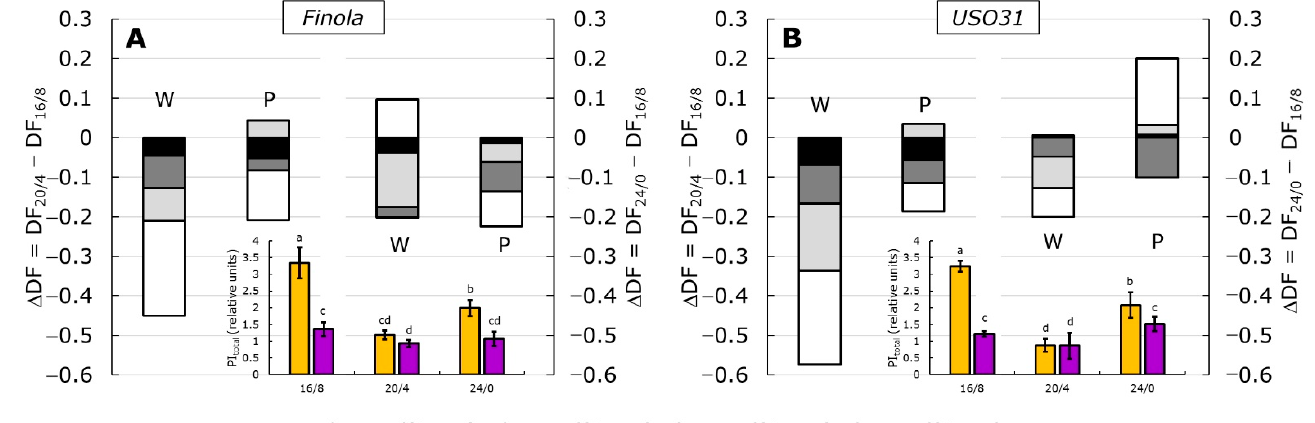
Figure 4. Relative changes in the difference in driving forces ( Δ DF) measured in Cannabis cultivars Finola ( A ) and USO31 ( B ) exposed to 16/8, 20/4, and 24/0 photoperiods and grown under white (W) and purple (P) light. Stacked columns are showing the difference in DFs at 20/4 (left columns per panel) and 24/0 (right columns per panel) photoperiods minus the DF at 16/8 (control). Each DF is calculated by summing up their partial driving forces: log γ RC /(1 − γ RC ), log φ P0 /(1 − φ P0 ), log ψ E0 /(1 − ψ E0 ), and log δ R0 /(1 − δ R0 ). The performance index for energy conservation from exciton to the reduction of the final electron acceptor at PSI, PI total for each cultivar is shown in the inserts. Yellow bars represent plants grown under white light, while purple bars represent plants grown under purple light. Results are shown as the mean of five independent measurements (n = 5) ± SD. Different letters represent a significant difference at p ≤ 0.05 (ANOVA, LSD).